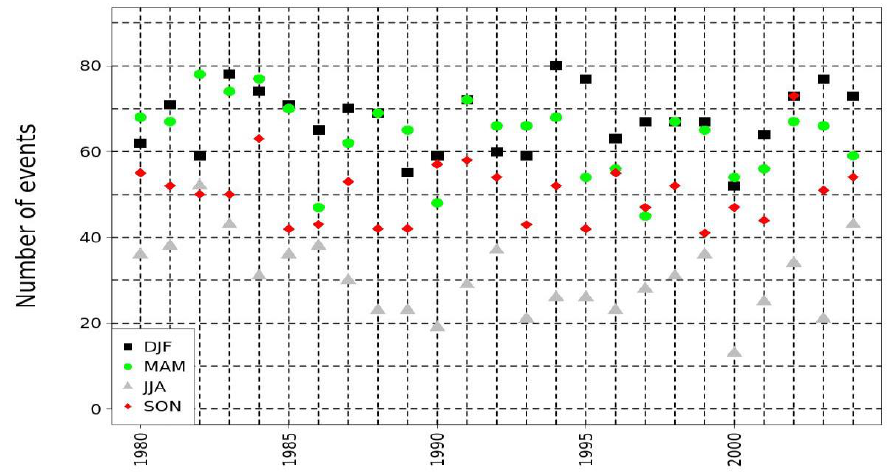
Figure 4. Quantification of halite crystallization events on seasonal basis using Athens-Hellinikon HNMS station data, in the period 1980–2004. Black squares indicate winter (DJF) values, green circles spring (MAM), grey triangles summer (JJA) and red diamonds autumn (SON).